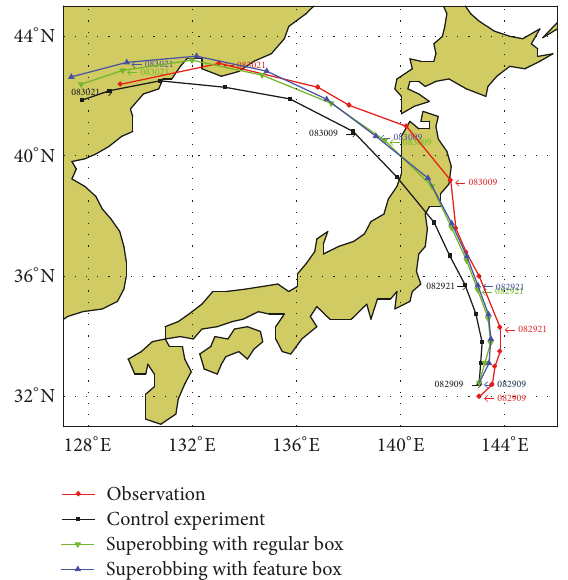
Figure 7: Forecasted paths of Typhoon Lionrock